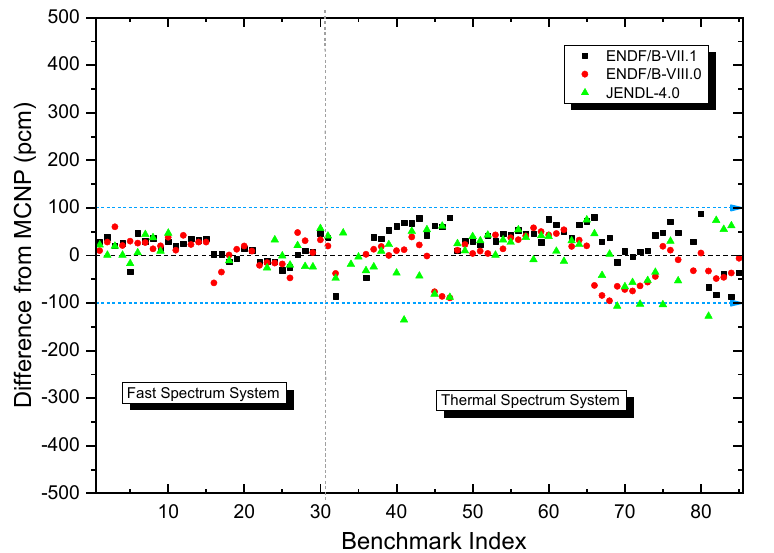
Table 7. The RMS difference between k eff results by McCARD and MCNP calculations.